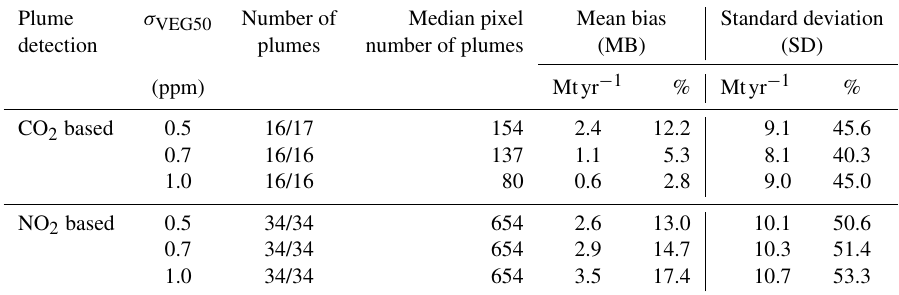
Figure 7. Time series of estimated CO 2 emissions of Berlin using a constellation of three satellites (#a, #c and #e) with medium-noise instruments ( σ VEG50 = 0 . 7ppm). The plumes were detected from (a) the CO 2 and (c) the NO 2 observations. The error bars show constant errors of 10.0Mtyr − 1 corresponding to the SD of the differences between estimated and real emissions. (b, d) The boxplots show the difference between estimated and CO 2 emissions at overpass of Berlin for six satellites. The boxes denote the range between 25th and 75th percentiles, orange lines are median values, and whiskers are 5th and 95th percentiles. The numbers above the boxes are the number of cases for which emissions could be estimated for all three scenarios (first number) and the number of successful emission estimates for each scenario (second number). Table 3. Mean bias (MB) and standard deviation (SD) of differences between estimated CO 2 emissions and emissions at overpass time (10:00–11:00UTC) for Berlin based on observations with six satellites. The CO 2 plume was either detected from CO 2 or NO 2 observations (high-noise scenario). The results are for line densities computed from the sub-polygon means. Plume σ VEG50 Number of Median pixel Mean bias Standard